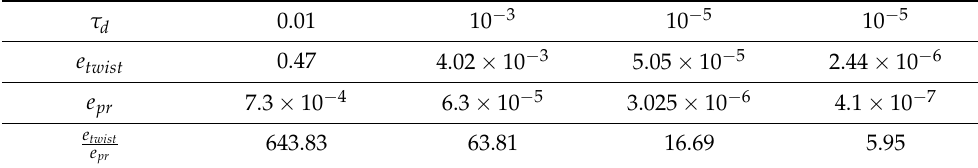
Table 3. The results of simulation of control laws with